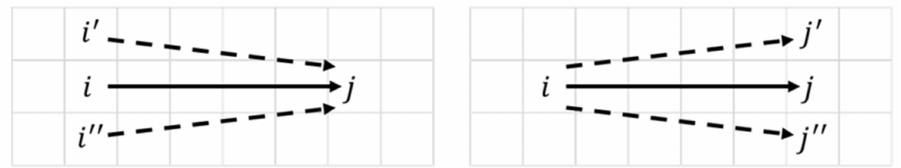
Figure 1. Spatial spillover effects. Left : origin-based; Right :